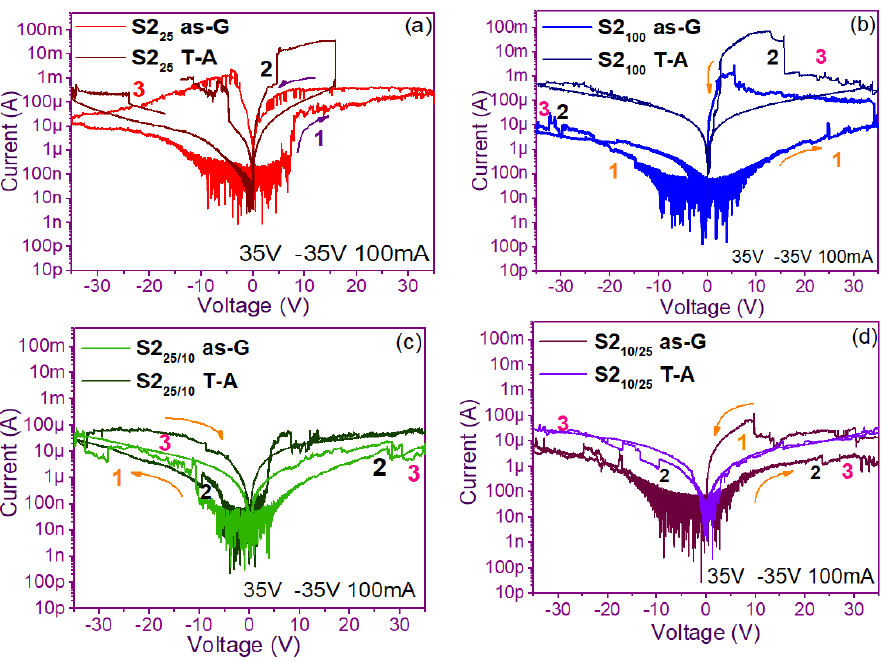
Figure 4. Pristine I-V curves ( a ) S2 25 as-G and T-A, ( b ) S2 100 as-G and T-A, ( c ) S2 25/100 as-G and T-A, ( d ) S2 100/25 as-G and T-A. ( d ) S2 100/25 as-G and